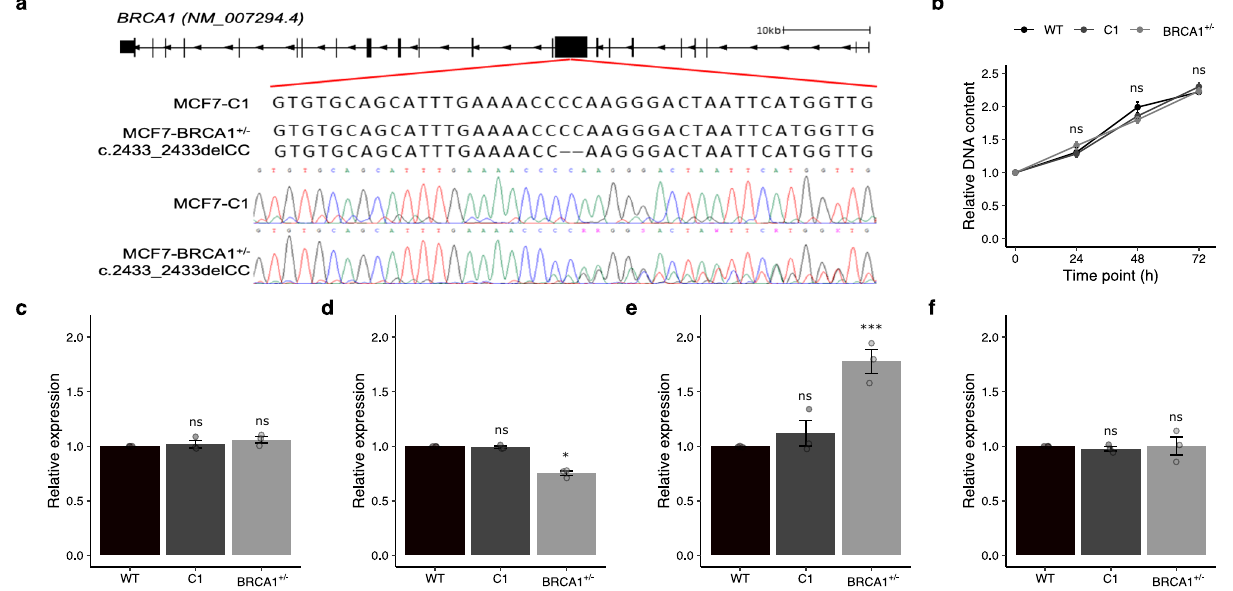
Fig. 2 Characterisation of MCF7 – WT, and isogenic MCF7 – C1, and MCF7 – BRCA1 + / − cell lines. a Sequence of heterozygous pathogenic BRCA1 c.2432_2433del variant introduced by CRISPR-Cas9. b Relative proliferation of MCF7 – WT and clonally expanded CRISPR-Cas9 MCF7 – C1 and MCF7 – BRCA1 + / − cells for 72 h post seeding. Relative expression of c BRCA1, d ESR1, e CYP1A1, and f SULT1A1 for MCF7 – WT, MCF7 – C1 and MCF7 – BRCA1 + / − cells. 4-OHE2 4-hydroxyestradiol, MMC Mitomycin C, Error bars = standard error of the mean; ns = p > 0.05; * p < 0.05; ** p <